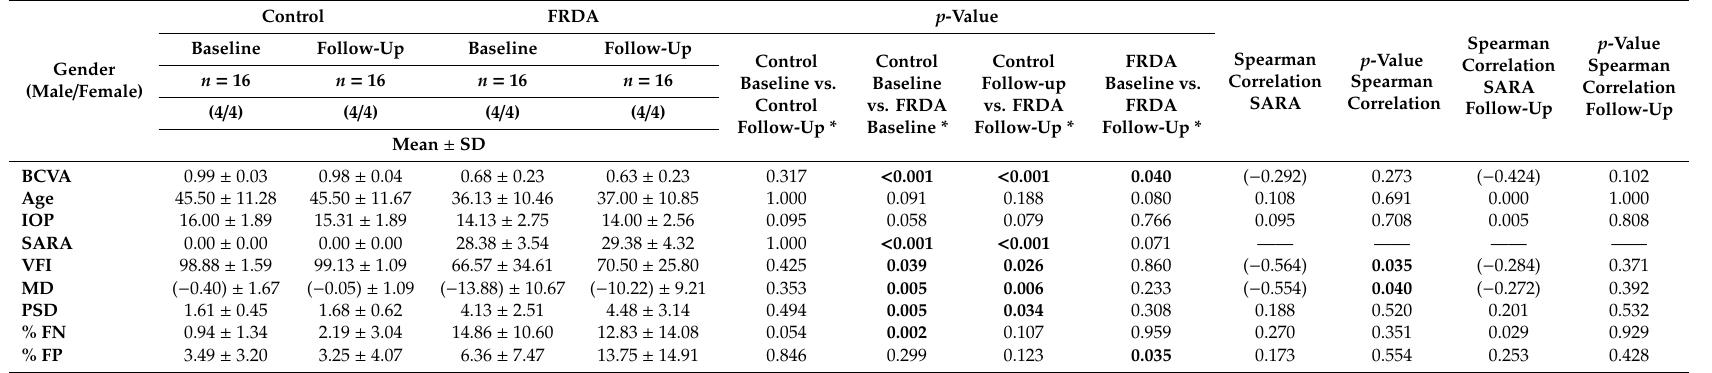
Table 1. Demographic data, SARA, and visual